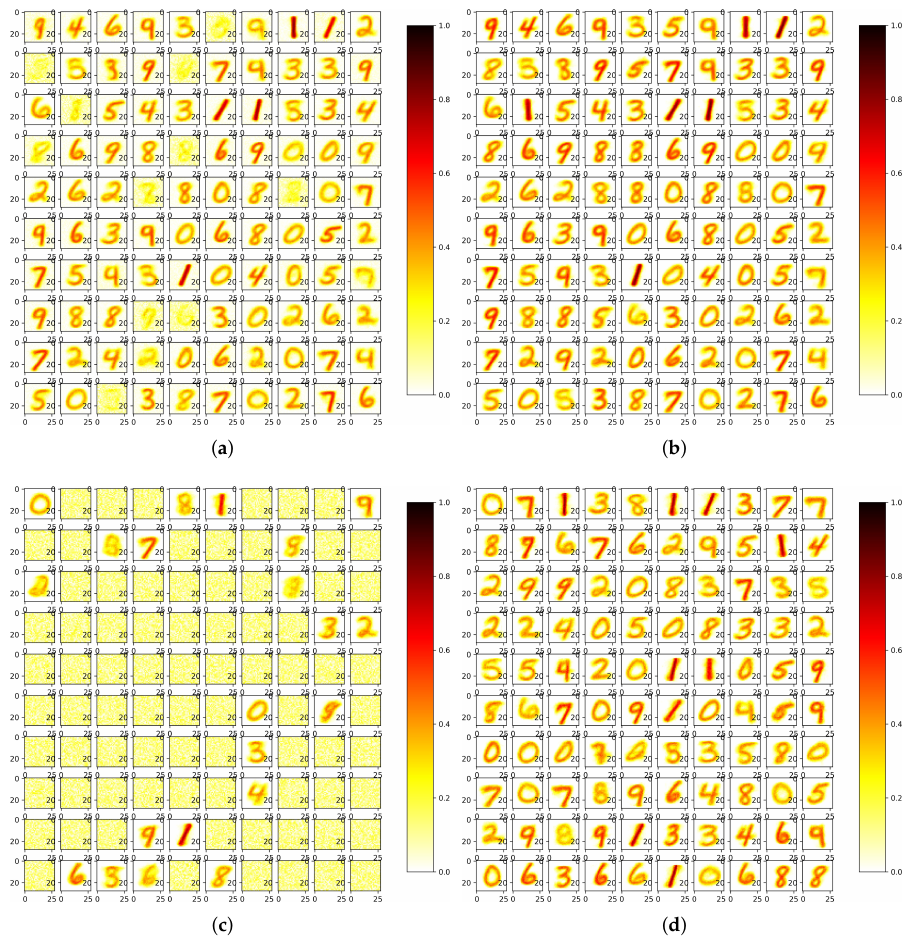
Figure 5. Weight results of neurons according to ( a ) 10,000 NOI and ( b ) 180,000 NOI when the conventional V th variation-based adaptation is applied, and ( c ) 10,000 NOI and ( d ) 180,000 NOI when the sensory adaptation is